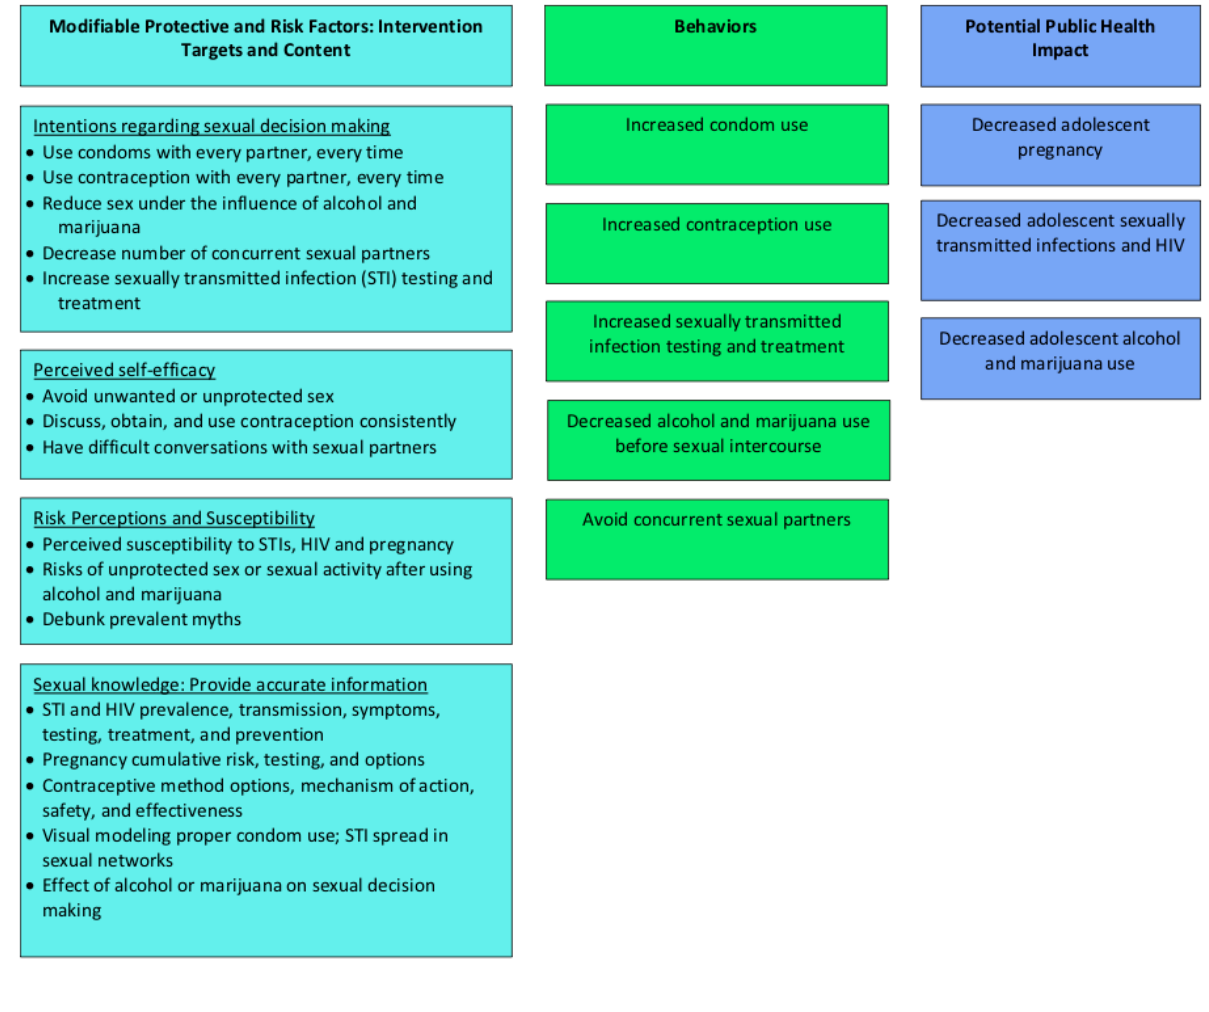
Figure 1. Focused logic